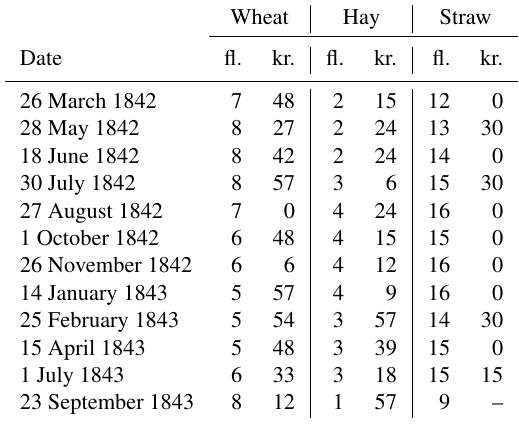
Table 1. Saturday’s market prices of wheat ( Metzen , 51.487L), hay ( Zentner , 56.006kg), and straw (60 shocks) in Opava (Moravian Silesia) on selected dates during 1842 and 1843. Prices are ex- pressed in gulden (Florin, fl.) and kreutzer (Kreutzer, kr.) of Vienna currency. Source of data: Troppauer Zeitung